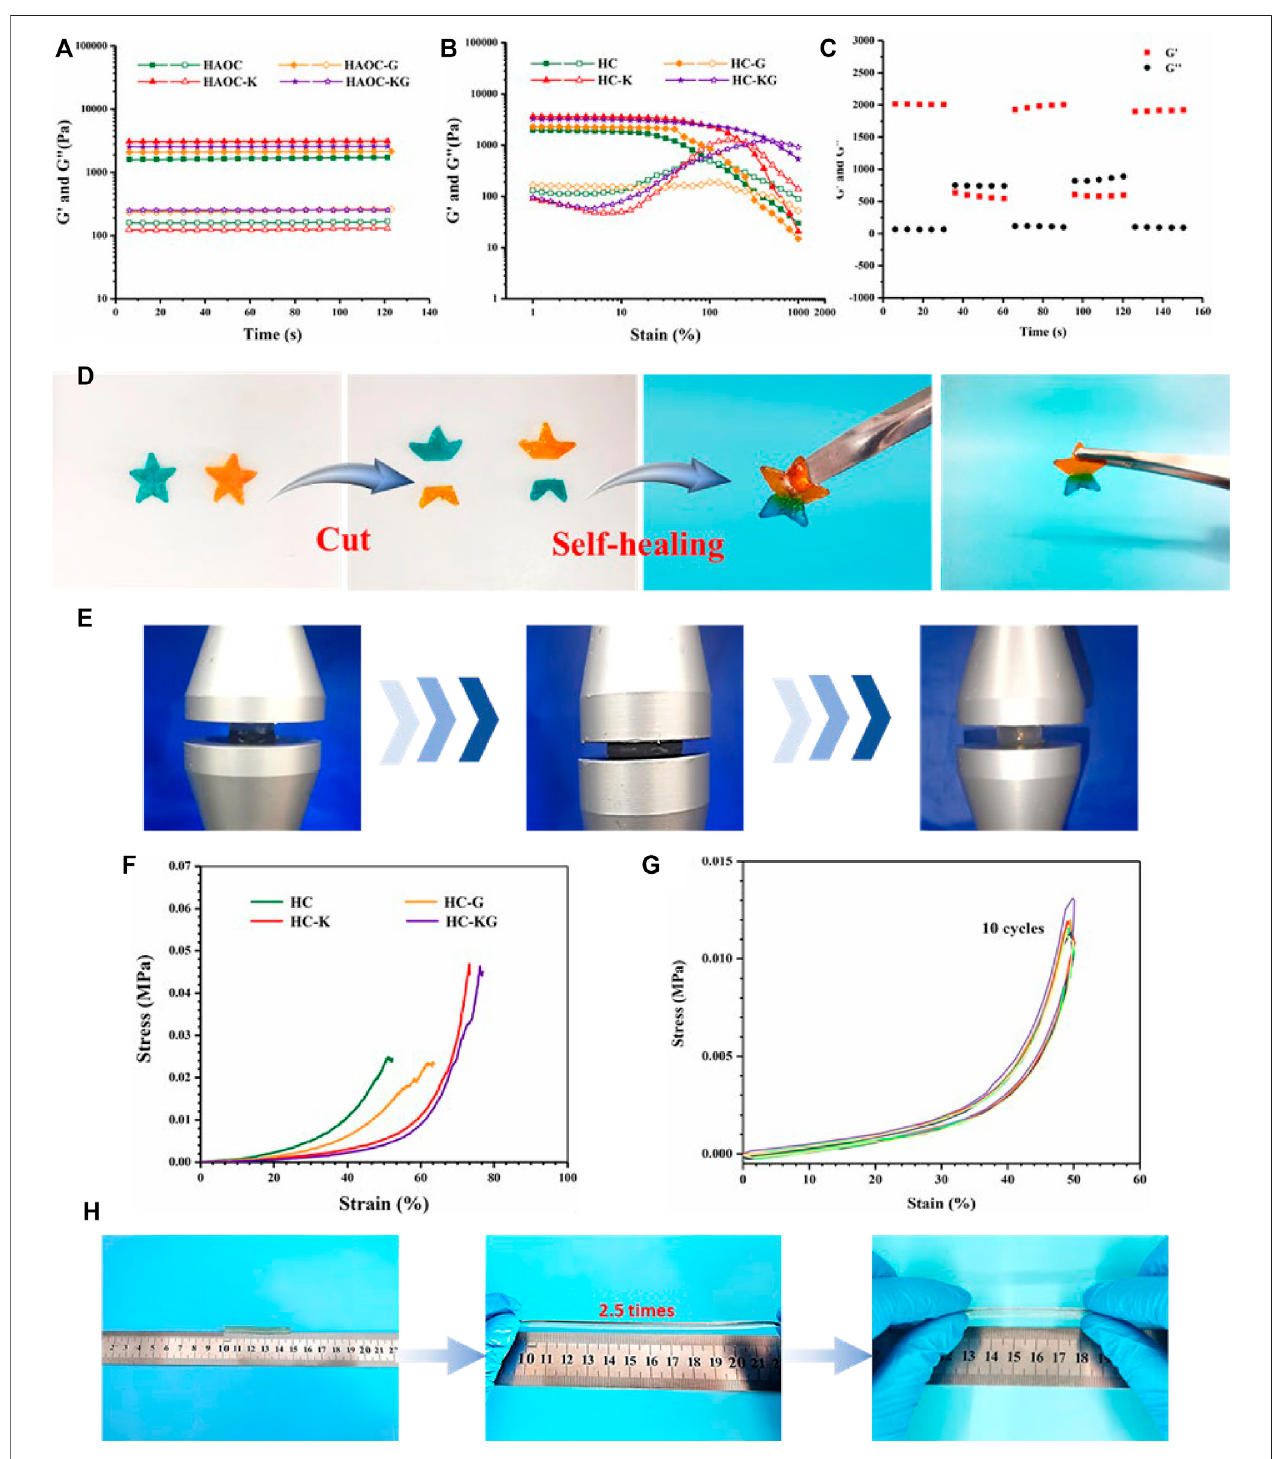
FIGURE 2 | Mechanical properties of the series hydrogel based on HA-ADH and OCS. Rheological time sweep (A) and strain sweep (B) of HC, HC-K, HC-G, and HC-KG hydrogels. (C) Rheological time sweep under alternative switching of low and high strain of the HC-KG hydrogel. (D) Quick self-healing property of the HC-KG hydrogel. (E) CompressionprocessoftheHC-KGhydrogel. (F) Compressivestrain – stresscurveofHC,HC-K,HC-G,andHC-KGhydrogel. (G) Cycliccompressivetest of the HC-KG hydrogel. (H) Stretchability of the HC-KG hydrogel.